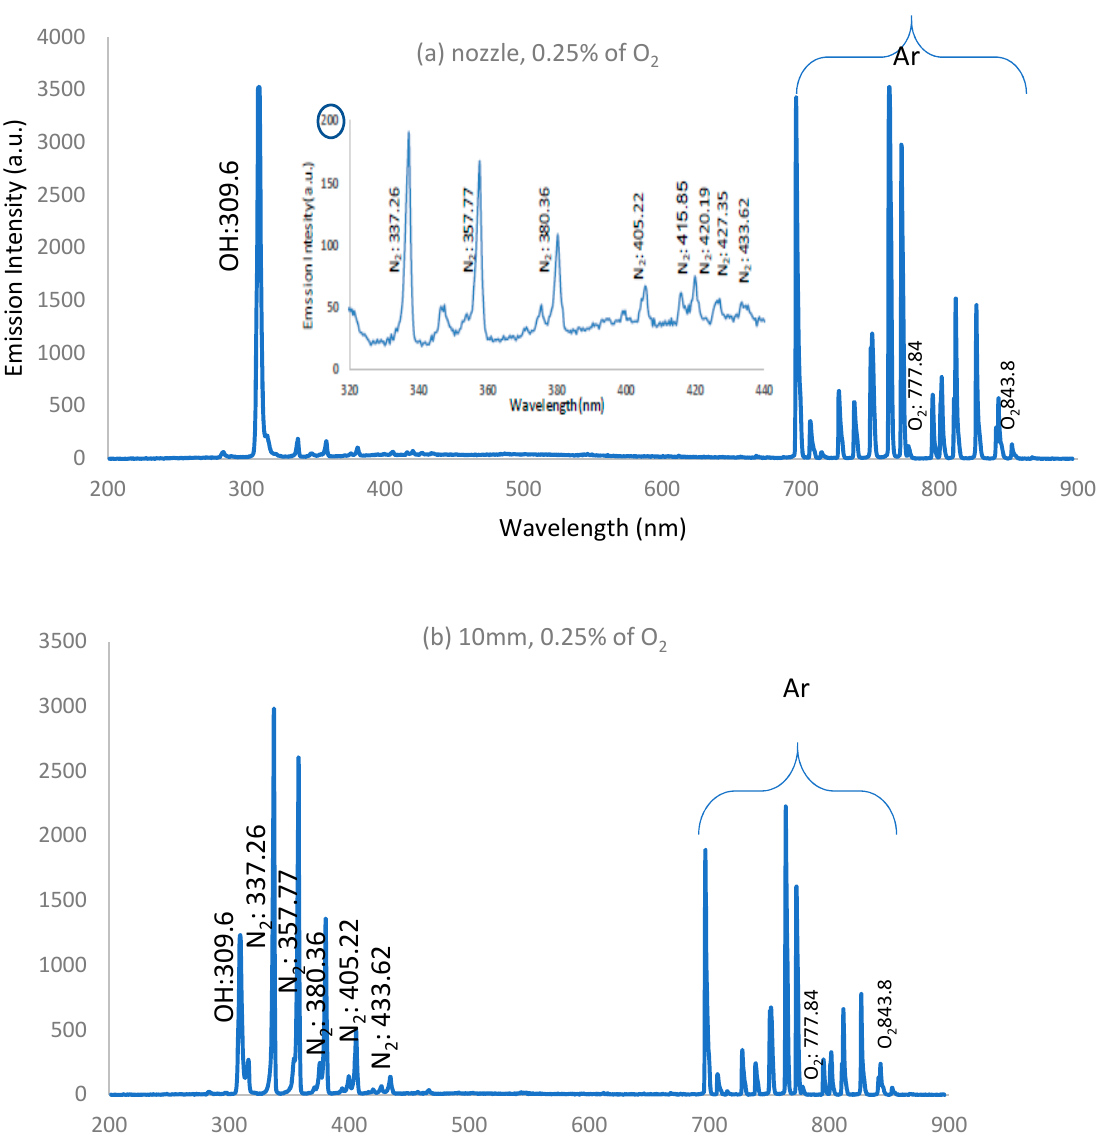
Figure 13. Optical emission spectra of APPJ using oxygen/argon admixture discharge at an applied flow rate of 0.25% of O 2 for ( a ) nozzle and ( b ) 10 mm.